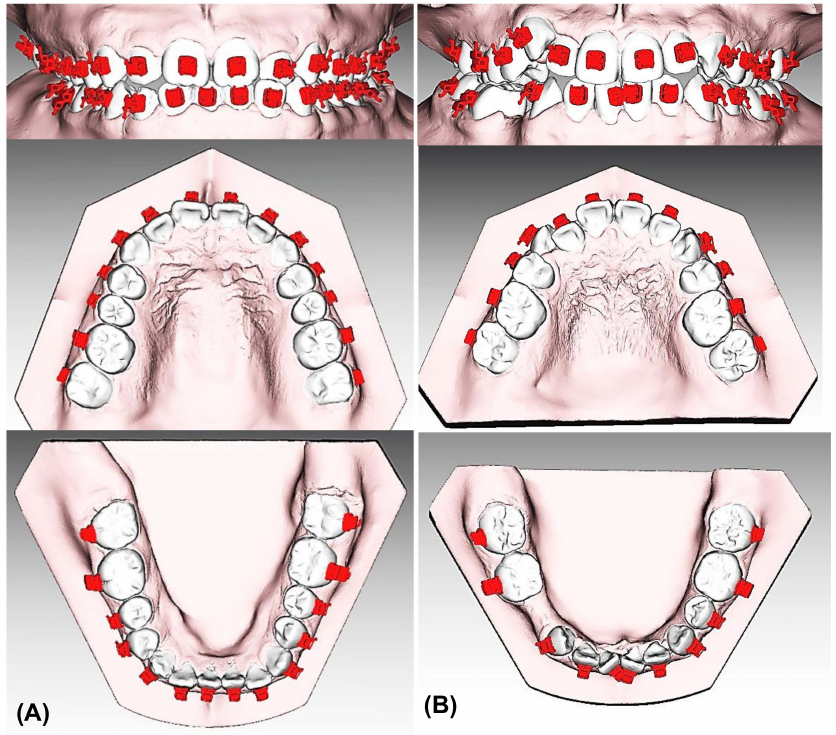
Figure 3. On the digital interface, Bioquick brackets were positioned virtually to the individual tooth surface using 3Txer software (CENOS co, Indeokwon, Gyeonggido, Korea). ( A ) Noncrowded case, ( B ) Crowded